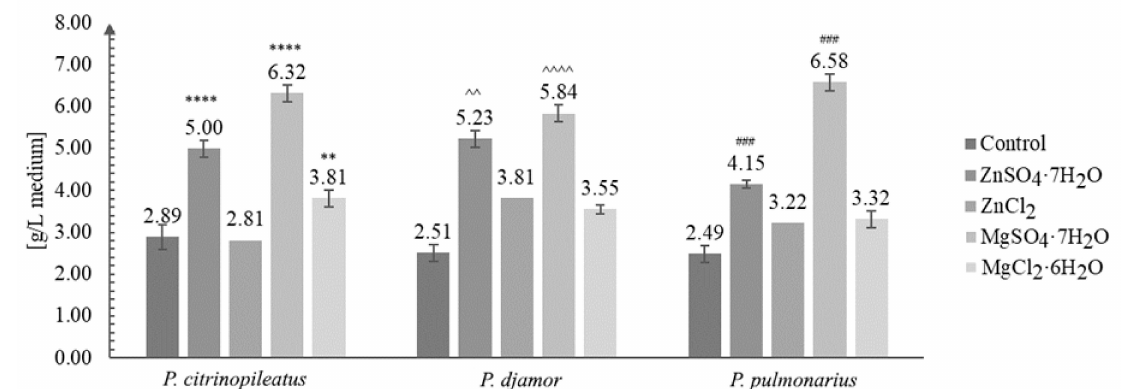
Figure 1. Biomass obtained after in vitro culture of Pleurotus citrinopileatus , Pleurotus djamor , and Pleurotus pulmonarius on the liquid Oddoux medium (g/L of medium) (one-way ANOVA with post-hoc Tukey’s test: ** p < 0.01 vs. P. citrinopileatus control; **** p < 0.0001 vs. P. citrinopileatus control; ˆˆ p < 0.01, ˆˆˆˆ p < 0.0001 vs P. djamor control; ### p < 0.001 vs. P. pulmonarius